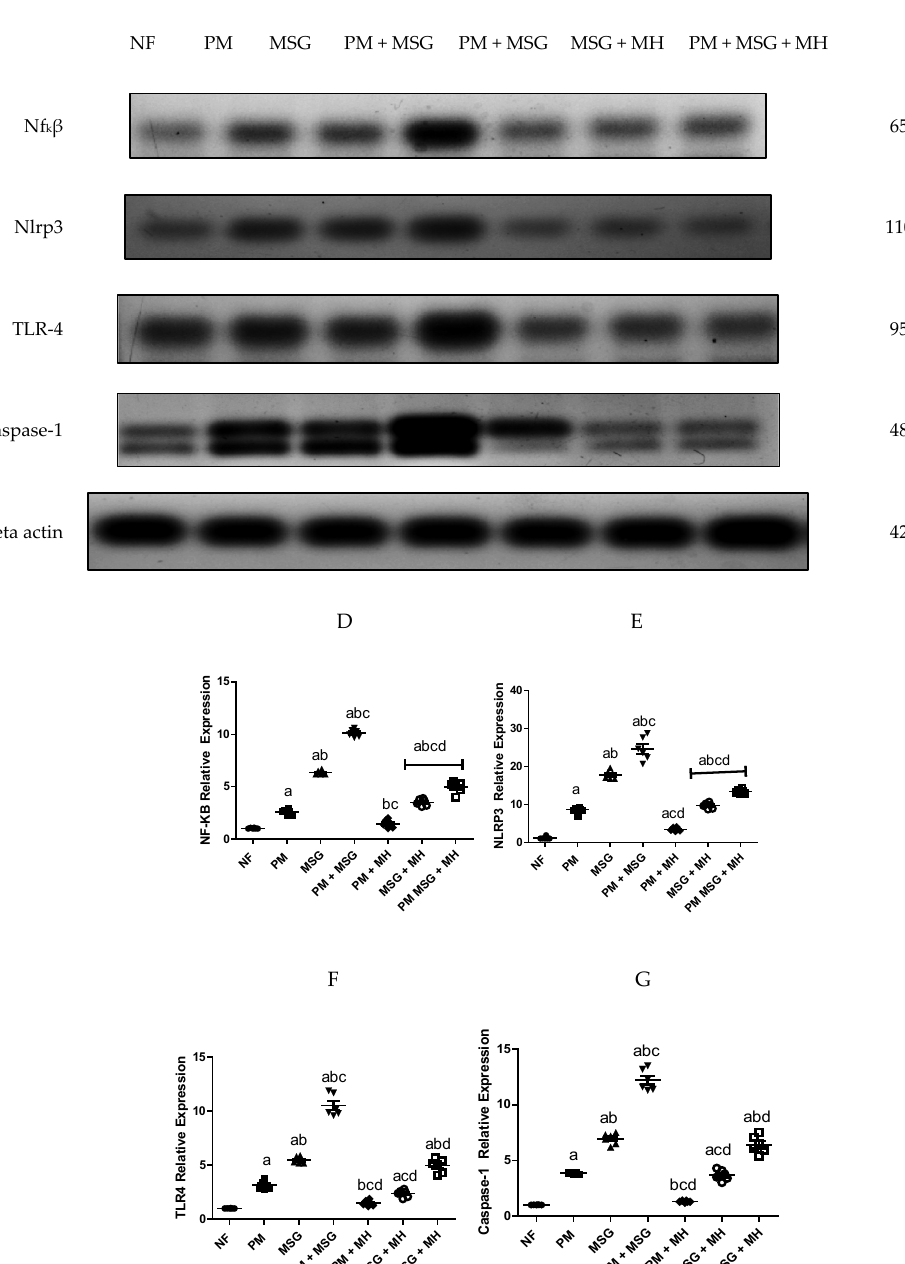
Figure 5. MH reestablishes inflammatory bio mediators of PM and/or MSG–fed rat pups: ( A , B ) effect of 60 mg/kg MH on brain inflammatory biomarkers of PM or/and 0.4 g/kg MSG rats measured by ELISA for IL-1 β and TNF- α content; ( C ) immunoblotting represented nuclear fractions of NF- K B, NLRP3 inflammasome, TLR4 and capsase-1. β -actin was used as housekeeping protein to ensure equal protein loading; and ( D – G ) the intensities of protein expressions were quantified relative to β -actin and expressed as a fold change of NF- K B, NLRP3 inflammasome, TLR4 and caspase-1. Data presented as mean ± SEM ( n = 6). a–d refers to significant difference relative to NF, PM, MSG, PM + MSG, respectively, at p < 0.05. Statistical analysis was performed using one-way ANOVA followed by Tukey’s post hoc test. [The data of the effect of MH on the control NF is not shown as it is not